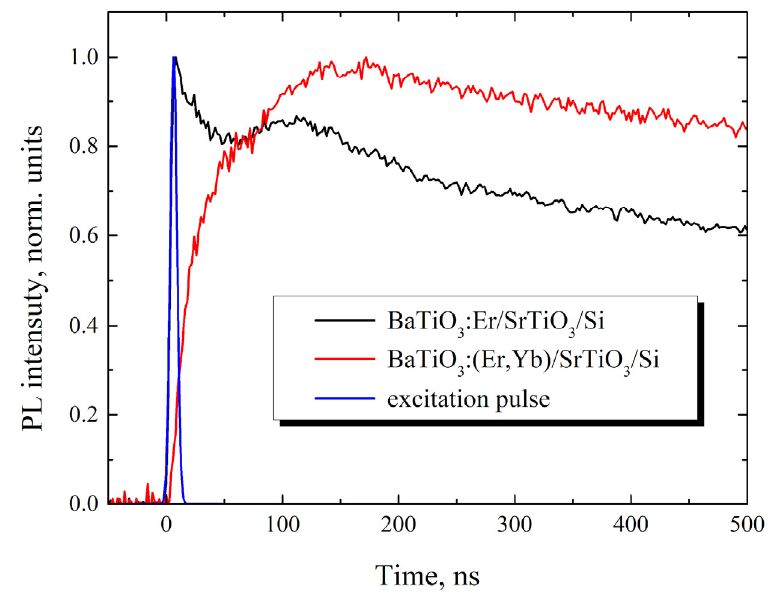
Figure 4. Time dependencies of the upconversion PL intensity (at 550 nm) observed in the BaTiO 3 :Er (sample B) and BaTiO 3 :(Er,Yb) (sample D) xerogel layers deposited on the SrTiO 3 /Si substrate. The PL kinetics were obtained under pulsed excitation at 980 nm with the pulse duration of 10 ns (blue curve). Each curve is normalized to the maximum value of the PL intensity.